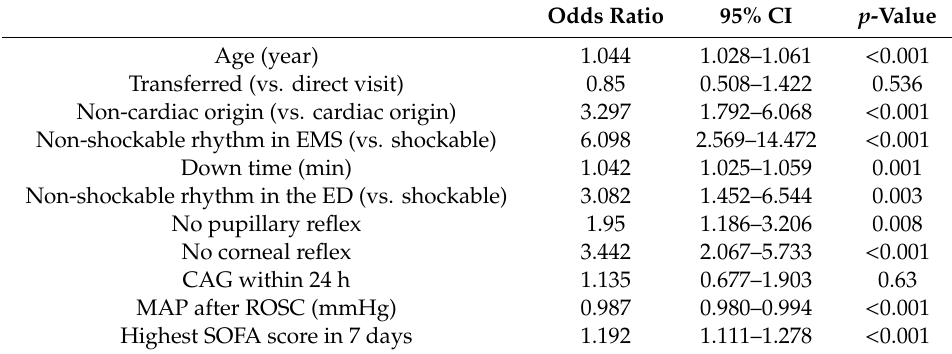
Table 3. Multivariate regression analysis for poor neurological outcomes after 6